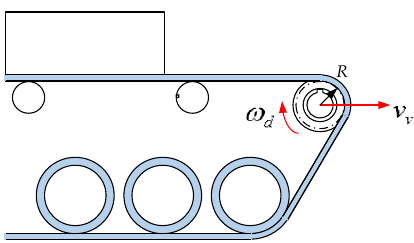
Figure 5. The relationship between body speed and driving wheel speed.